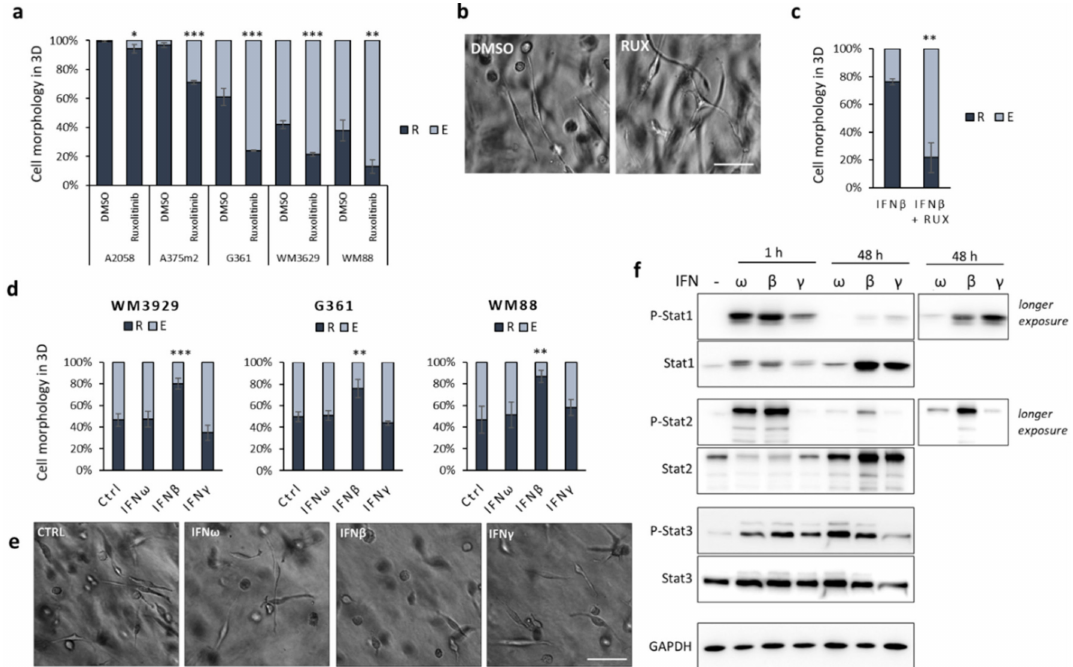
Figure 2. Role of IFN signalling in melanoma invasion plasticity. ( a ) Inhibition of Jak1 / 2 by Ruxolitinib promotes the elongated, mesenchymal phenotype of melanoma cells cultured in 3D collagen (48 h). ( b ) Representative image of WM3629 cells after 48 h in 3D collagen treated with DMSO or Ruxolitinib. ( c ) Quantification of morphology of WM3629 cells treated with IFN β alone or IFN β plus Ruxolitinib after 48 h in collagen. ( d ) Quantification of morphology of melanoma cells cultured in 3D collagen for 48 h after treatment with IFNs (overall exposure to IFNs took 96 h). ( e ) Representative images of WM3629 cells after 48 h in 3D collagen treated with IFNs. ( f ) Immunoblotting detection of Stat transcription factors Stat1, Stat2 and Stat3 activation after 1 h and 48 h IFN treatment in WM3629 cells. Scale bar 100 µ m in both ( b ) and ( e ). R = round, E = elongated. p -values: *** p < 0.001, ** p < 0.01, * p < 0.05. Detailed information about Western blot can be found at Figure